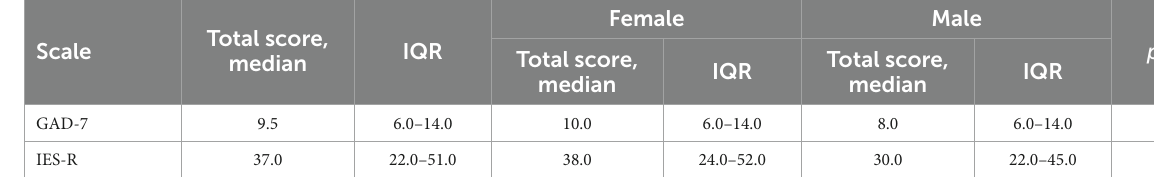
TABLE 4 Median of generalized anxiety disorder and post-traumatic stress disorder scores in the study sample and by gender.